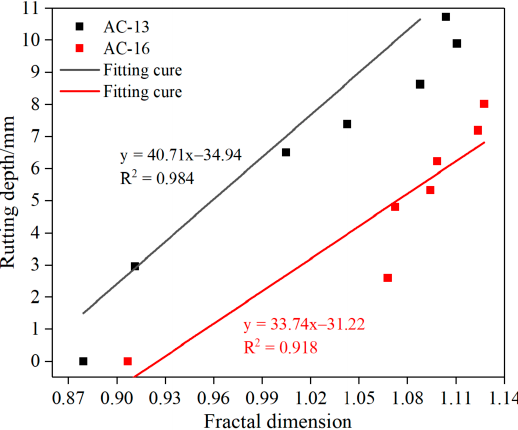
Figure 11. Relationship between fractal dimension and rutting depth.